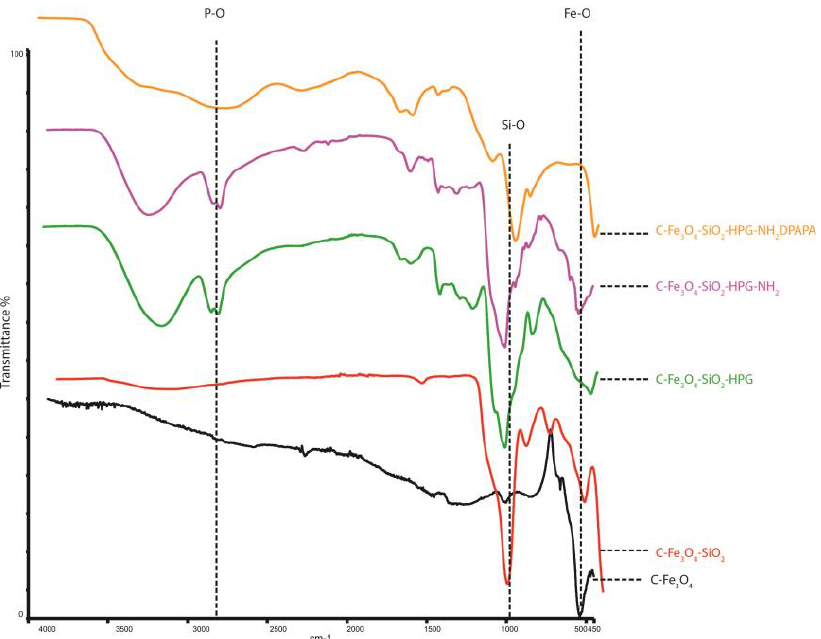
Figure 4. FTIR spectra of NPs and nanoconjugates.